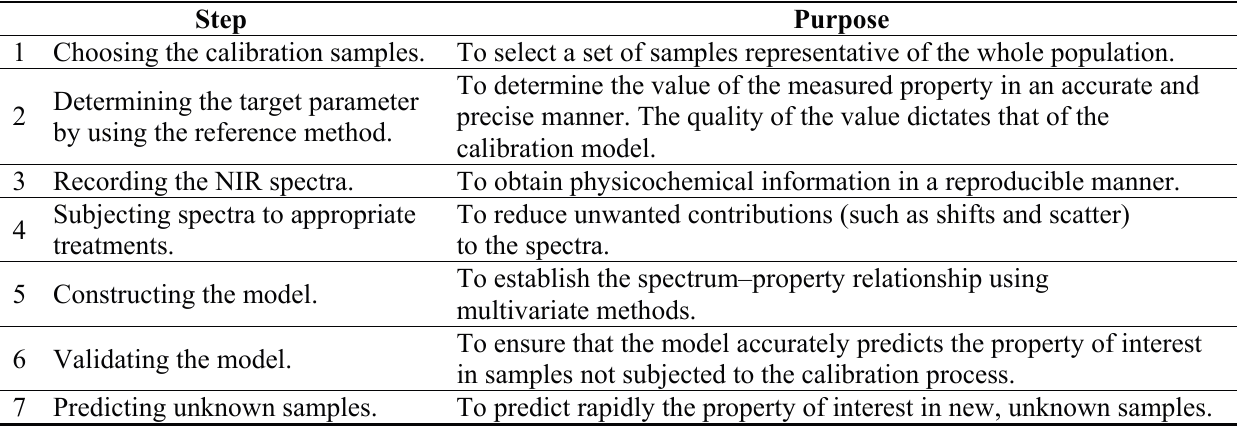
Table 1. Steps in the multivariate model-construction